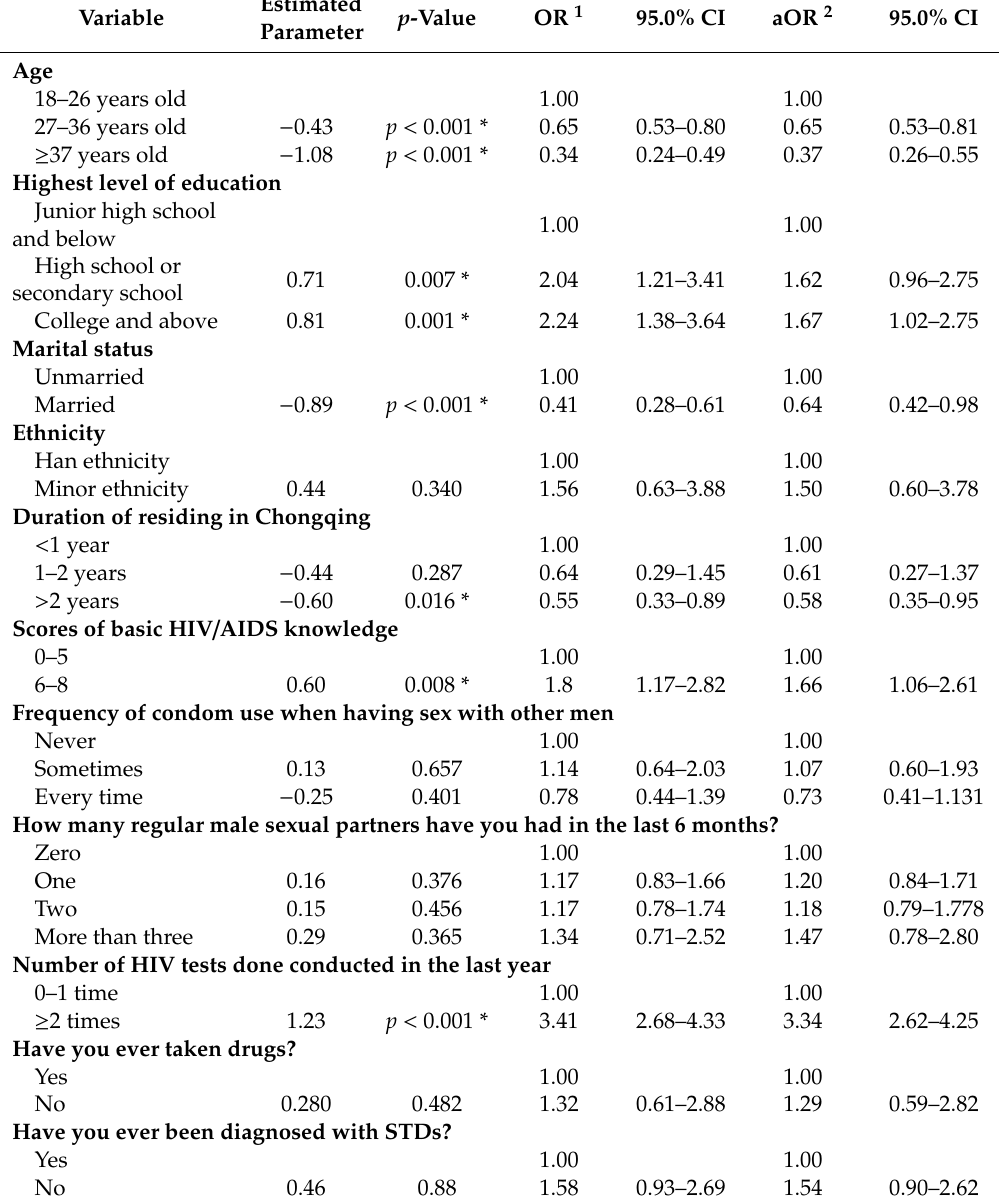
Table 4. Logistic regression analysis of the factors a ff ecting HIVST among MSM in Chongqing,